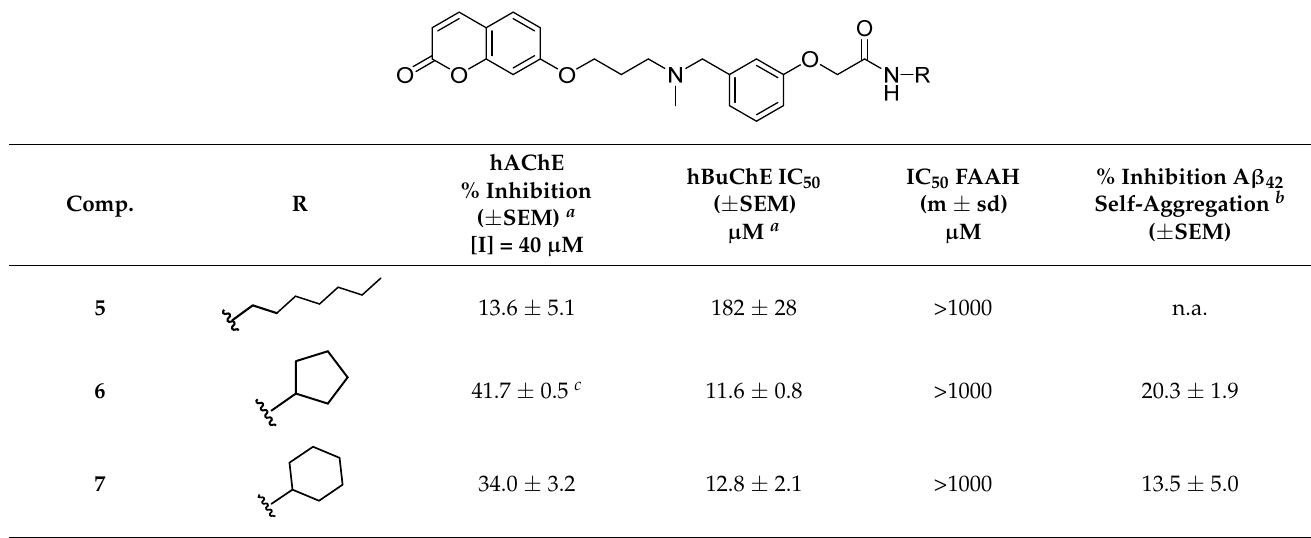
a Human recombinant AChE and BuChE from human serum were used. IC 50 values represent the concentration of inhibitor required to decrease enzyme activity by 50% and are the mean of two/three independent measurements, each performed in duplicate. SEM = standard error of the mean; b [A β 42] = [inhibitor] = 50 µM; c IC 50 = (59.4 ± 1.0) µM; na stands for not active, i.e., % inhibition lower than 10% at the tested concentration.